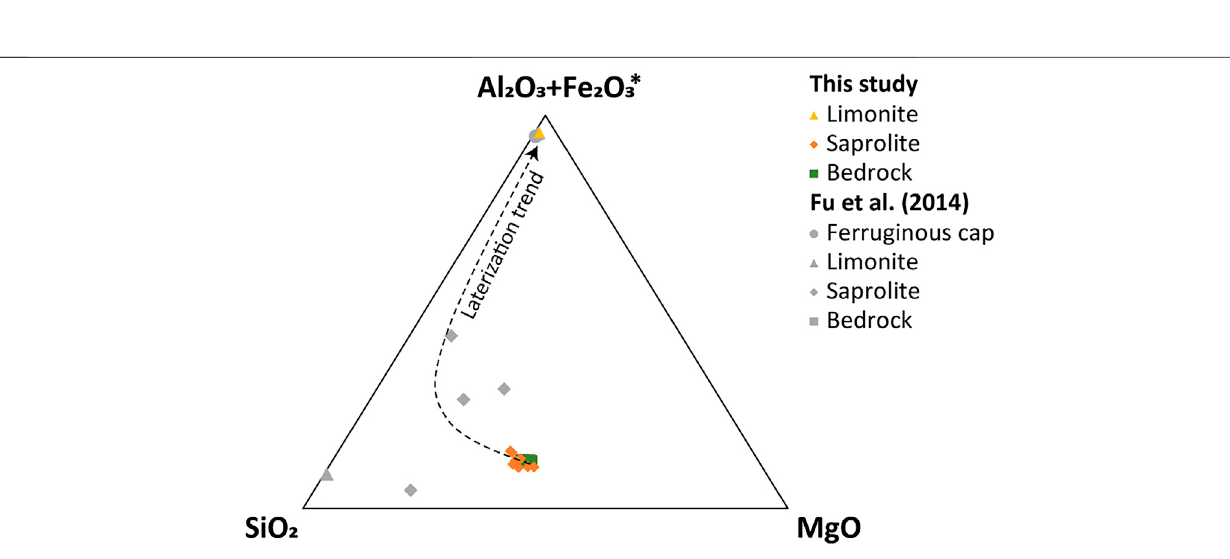
Frontiers in Earth Science |